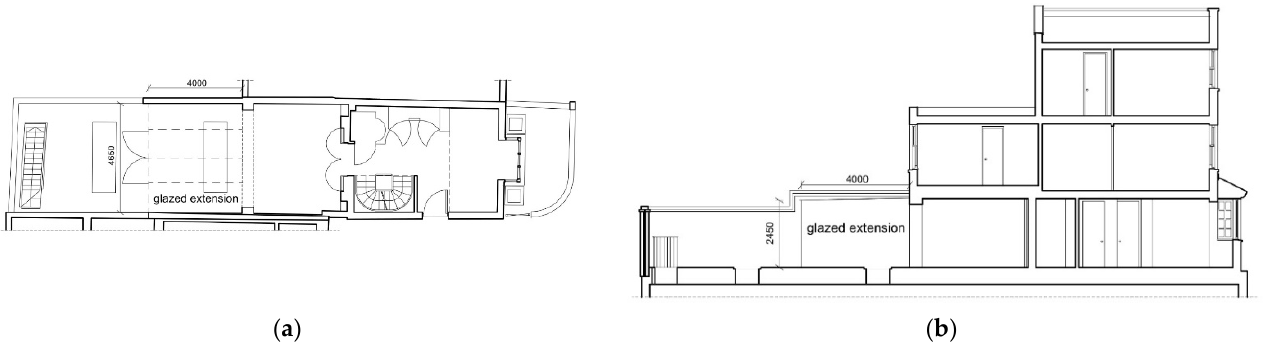
Figure 14. House at Christchurch in London: ( a ) ground plan; ( b ) longitudinal section (figures de- veloped by the author based on the architect’s drawings).